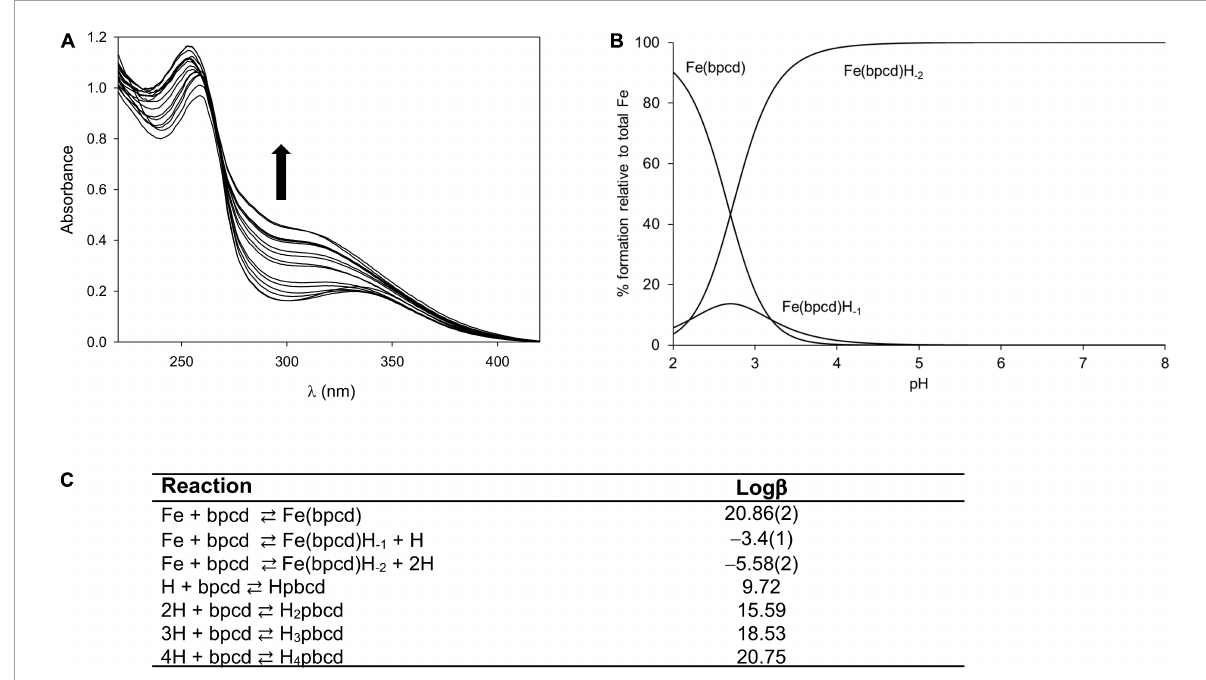
FIGURE3 Spectral changes observed when increasing the pH from 0.0 to 2.0 in solutions containing equimolar amounts of the bpcd ligand (0.088 mM) and FeCl 3 (A) . Speciation for the Fe 3 + /bpcd system (C Fe = 1.0 mM, 1:1 metal/ligand molar ratio) calculated on the basis of the fitted constants in panel (C) (B) . Protonation (Leonzio et al., 2017) and formation constants for Fe(bpcd) species (standard deviation in parenthesis) (C) . Charges are omitted for clarity.